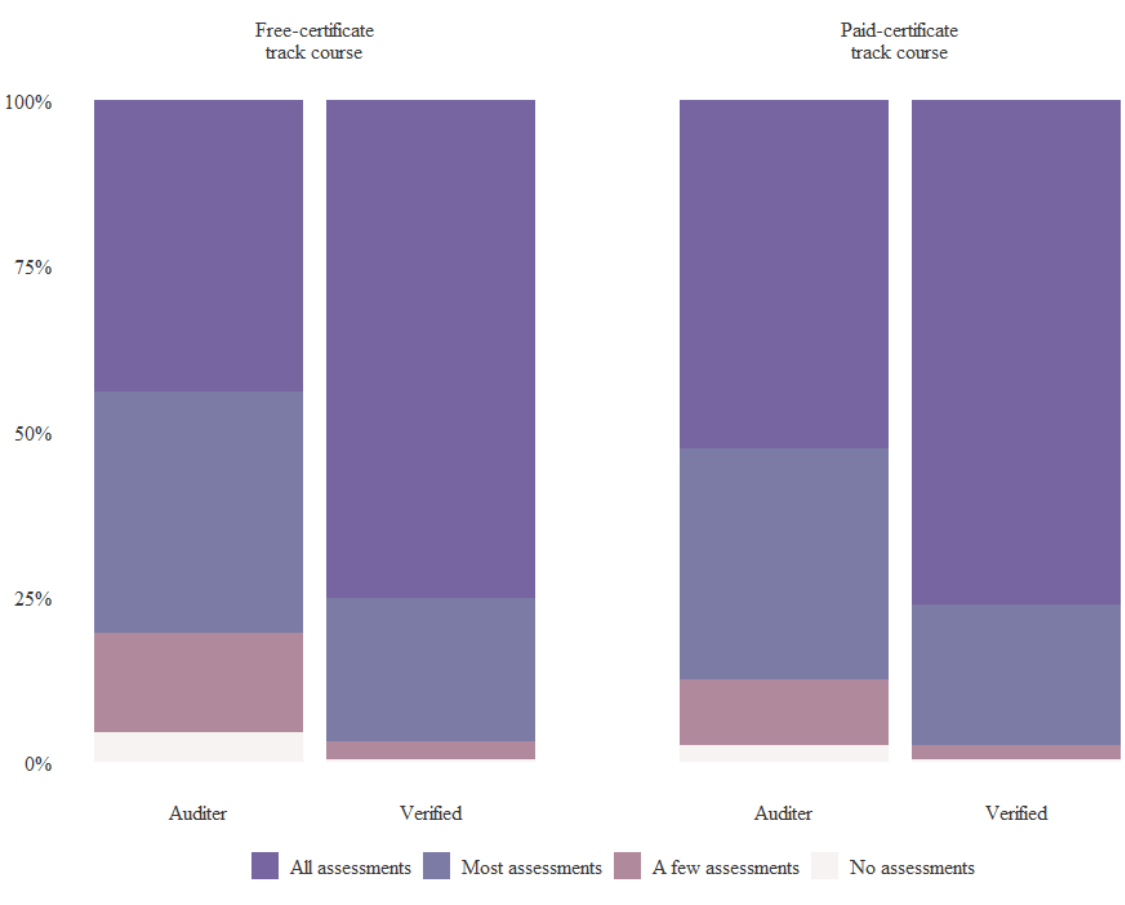
Figure 1. Case study 1: Assessment completion intentions on entrance